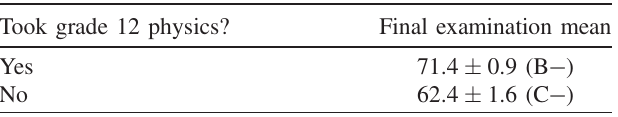
TABLE III. Final examination performance and whether the student took senior-level high school physics.